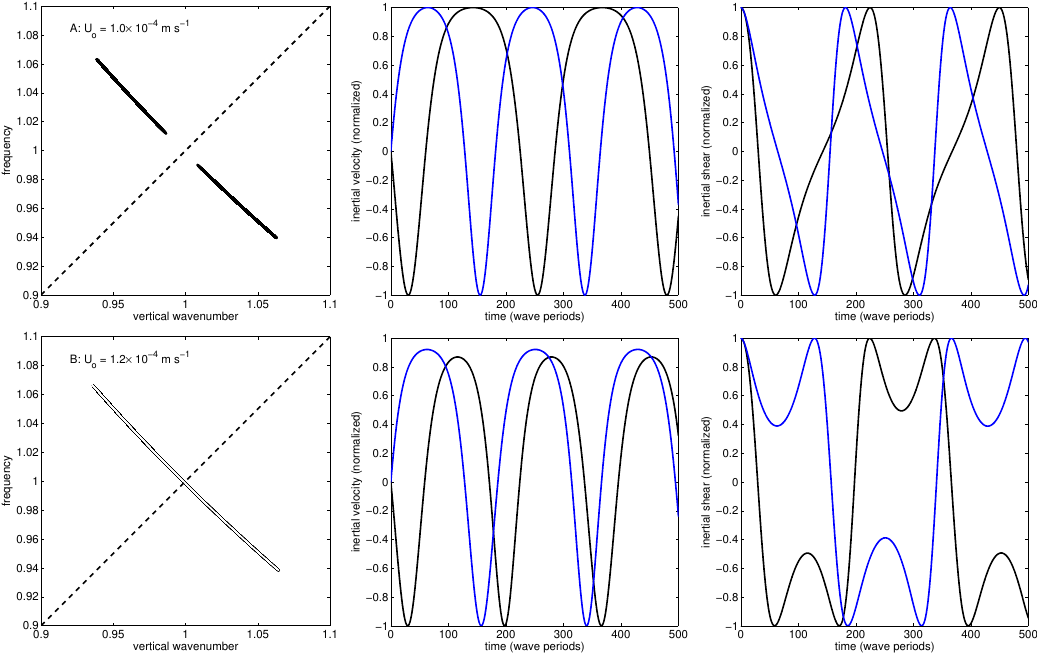
Figure 3. Solutions for the two high frequency members of the triad. Upper panels: U = 1.0 × 10 − 4 m s − 1 . Lower panels: U = 1.2 × 10 − 4 m s − 1 . Left panels: vertical wavenumber vs. frequency. In the high amplitude cases the two wave trajectories can not be distinguished and the lower frequency of that duo is over plotted as a thinner white line. Normalization of vertical wavenumber and frequency is provided by dividing the wavenumber-frequency pairs by the mean values for the two triads at t = 0. The dashed line represents the C ph = C z g resonance curve. Middle Panels: black and blue traces represent the inertial velocity following the ray path, normalized by U . Right Panels: Similarly, black and blue traces represent the inertial shear following the ray path, normalized by MU . In the low(er) amplitude case all phases of the background are sampled by the test wave. The high(er) amplitude case represents a resonant bound wave